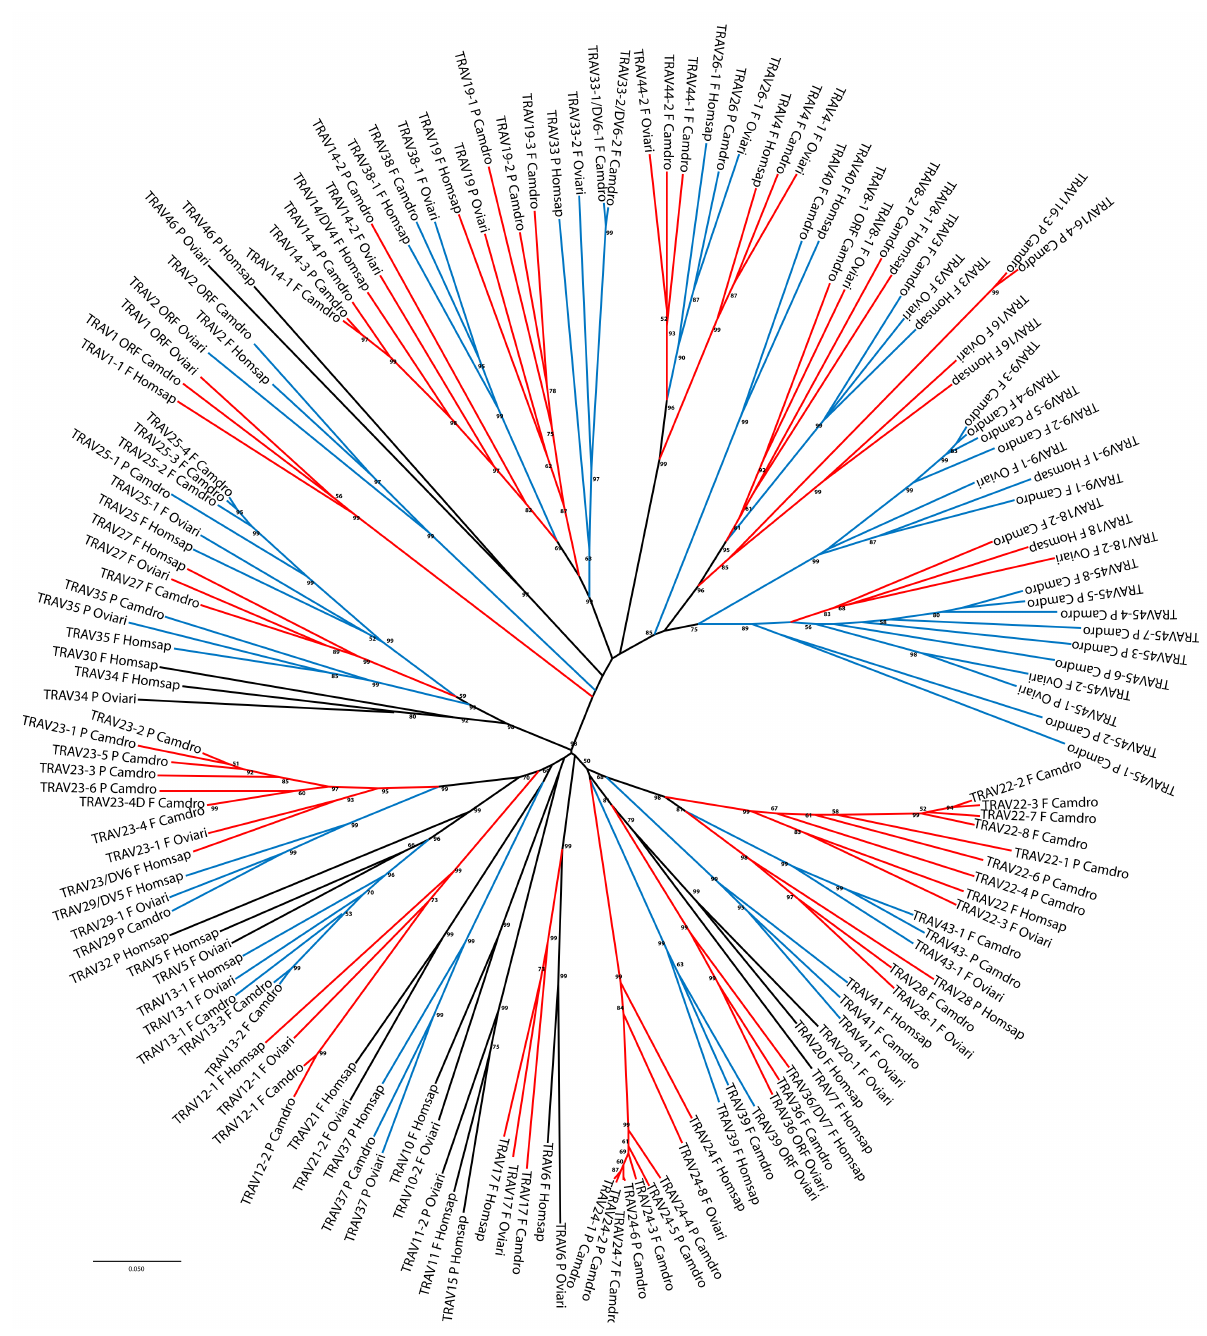
Figure 2. The neighbour-joining (NJ) tree inferred from the dromedary, sheep and human TRAV gene sequences. The evolutionary analyses were conducted in MEGA X [30,31]. The optimal tree with the sum of branch length = 19.33009914 is shown. The percentage of replicate trees in which the associated taxa clustered together in the bootstrap test (100 replicates) is shown next to the branches [36]. The tree is drawn to scale, with branch lengths in the same units as those of the evolutionary distances used to infer the phylogenetic tree. The evolutionary distances were computed using the p-distance method [33] and are in the units of the number of base differences per site. This analysis involved 159 nucleotide sequences. Codon positions included were 1st + 2nd + 3rd + Noncoding. All ambiguous positions were removed for each sequence pair (pairwise deletion option). There was a total of 405 positions in the final dataset. The orthologous TRAV genes formed monophyletic grouping that are alternatively highlighted in red and blue. The gene functionality according to IMGT rules (F: functional, ORF: open reading frame, P: pseudogene) is indicated. The IMGT 6-letter for species (Camdro, Oviari and Homsap) standardized abbreviation for taxon is